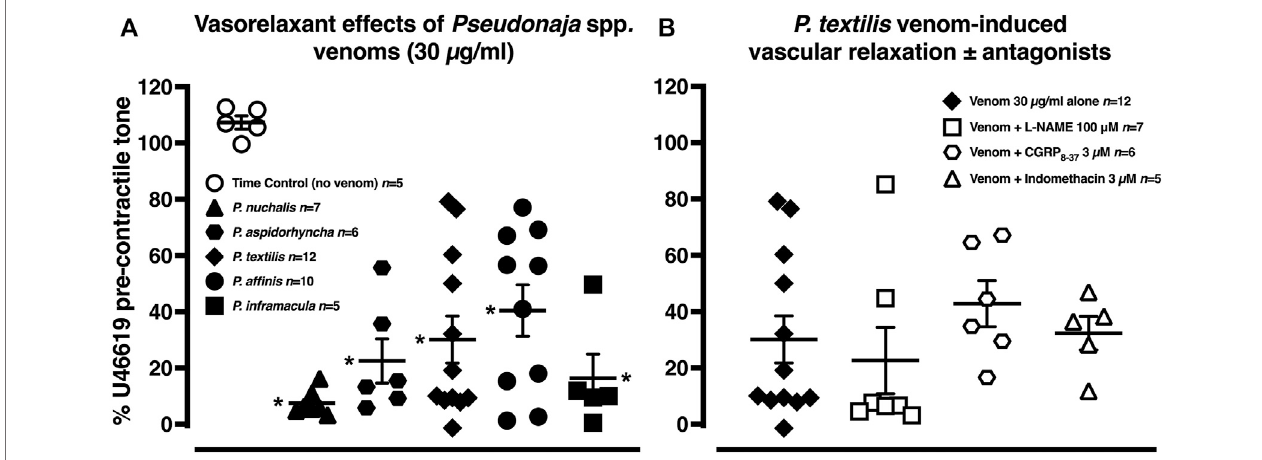
FIGURE 3 | (A) Vascular relaxant effects of Pseudonaja spp. venoms (each 30 µg/ml) in rat isolated mesenteric arteries pre-contracted with U46619 (0.1 µM). (B) Vasorelaxation effects of Pseudonaja textilis venom (30 µg/ml) in the absence or presence of antagonists of nitric oxide synthase (L-NAME 100 µM), calcitonin gene- related peptide (CGRP 8 – 37 3 µM) or cyclooxygenase (indomethacin 3 µM). Data are values of individual experiments expressed as a % of the pre-contractile U46619 tone.Horizontalbarsaremeanandverticalbars ± 1SEMof n arteriesfromseparaterats.* p < 0.05vstimecontrol(novenom),one-wayANOVAwithDunnett ’ s post hoc